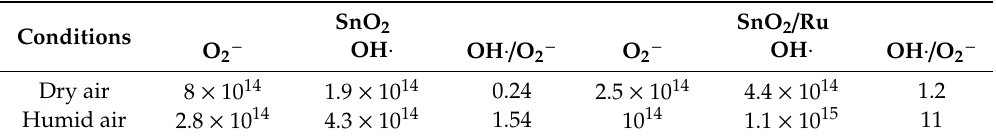
Table 2. Concentrations (spin / g) of O 2 − and OH · radicals on the surface of SnO 2 and SnO 2 / Ru samples in dry and humid